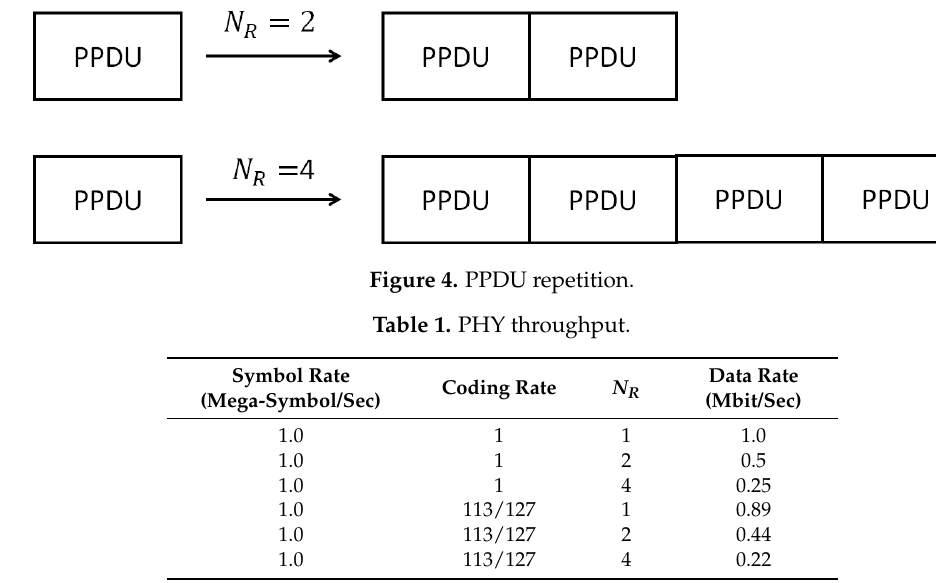
Figure 3. PPDU structure.